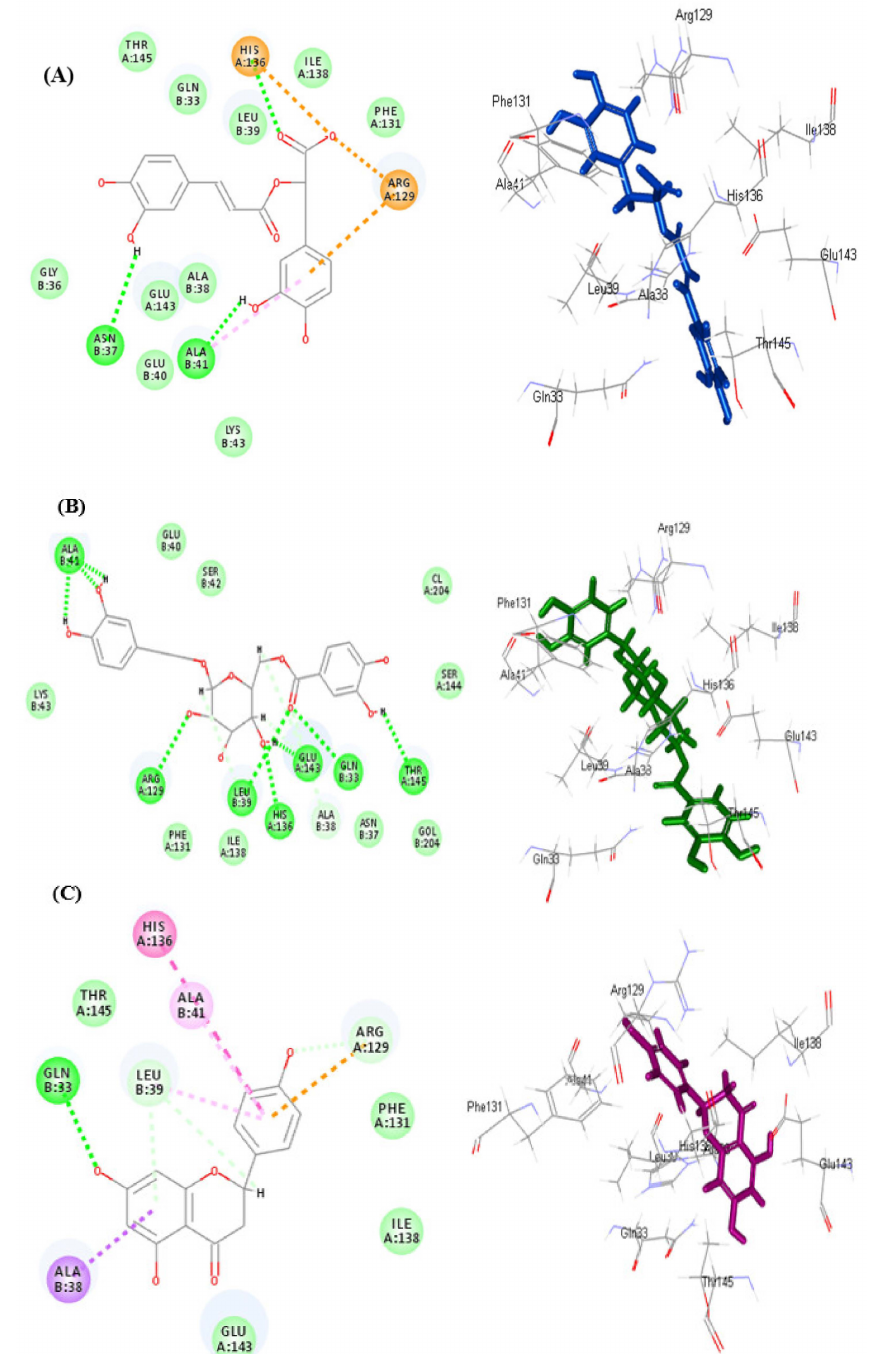
Figure 6. 2D and 3D of rosmarinic acid ( A ), fuhsioside ( B ), and naringenin ( C ) within the active sites of daf2 protein employing rule-based ionization mode; H-bonds (heavy green dotted bonds); C-H bonds (light green dotted bonds); π -ionic bonds and attractive charges (orange dotted bonds); π - δ bond (violet dotted bonds); π - π bonds (heavy purple dotted bonds) and π -alkyl bonds (light purple dotted